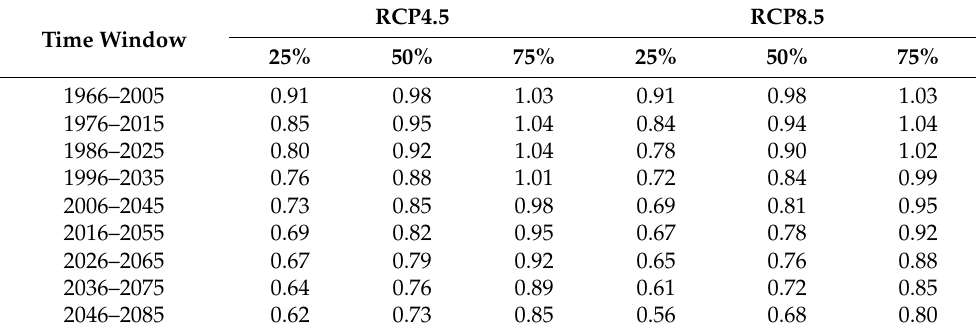
Table 6. Mean of factors of change percentiles for s k in the study region. RCP4.5 Time Window